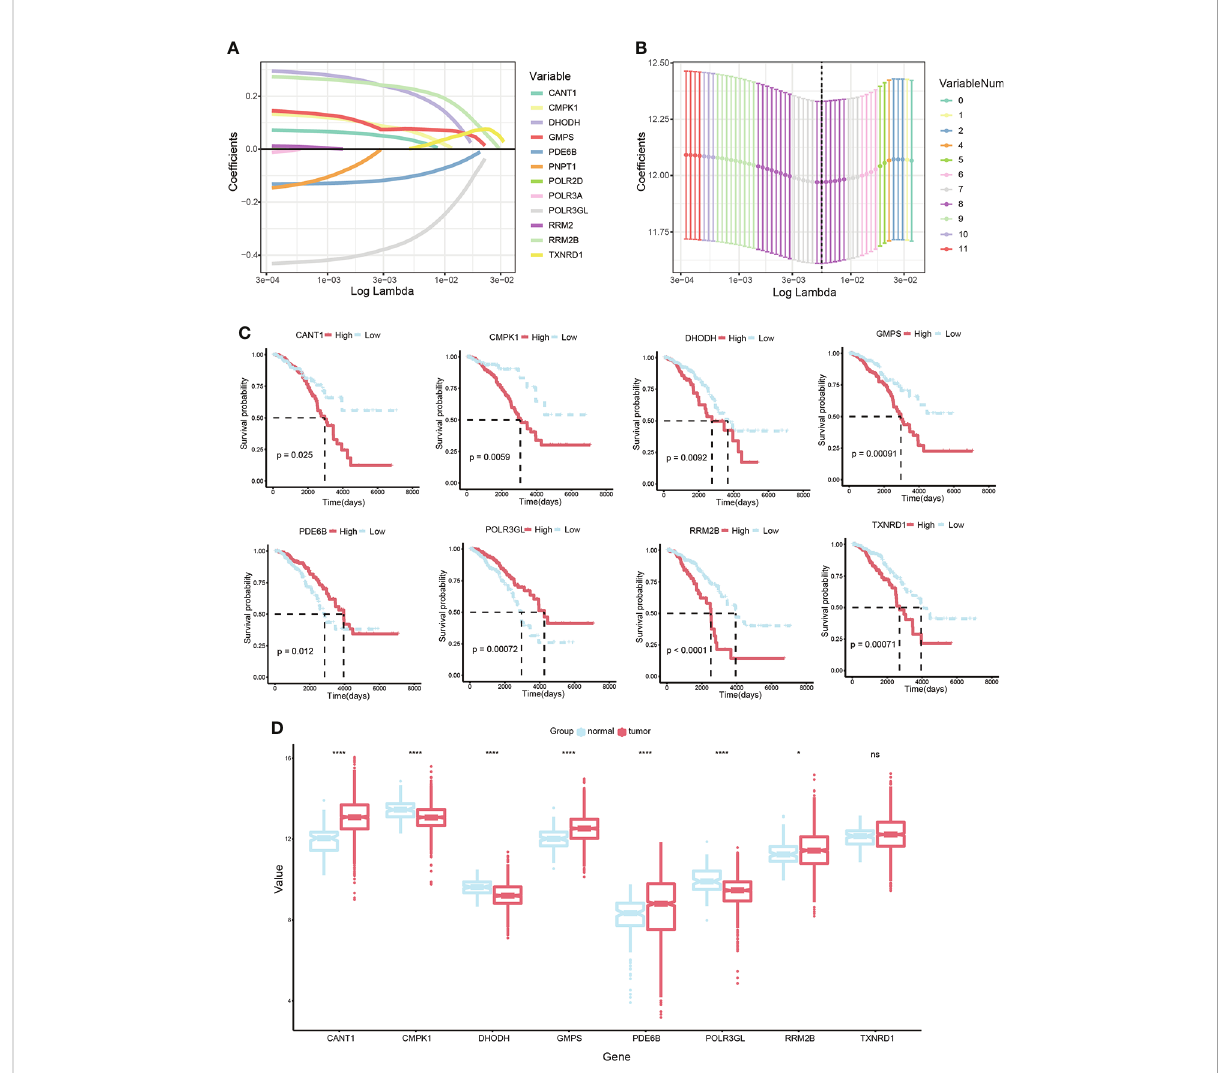
FIGURE 3 Development of a PMI signature in BC. (A, B) LASSO Cox regression analysis to select candidate PMGs for the signature. (C) The KM survival curves of eight selected PMGs based on expression levels and OS. (D) Estimation over the mRNA expression levels of eight signature-contained PMGs in the training cohort. *p< 0.05; **p< 0.01; ***p< 0.001; ****p< 0.0001; ns, no signi fi